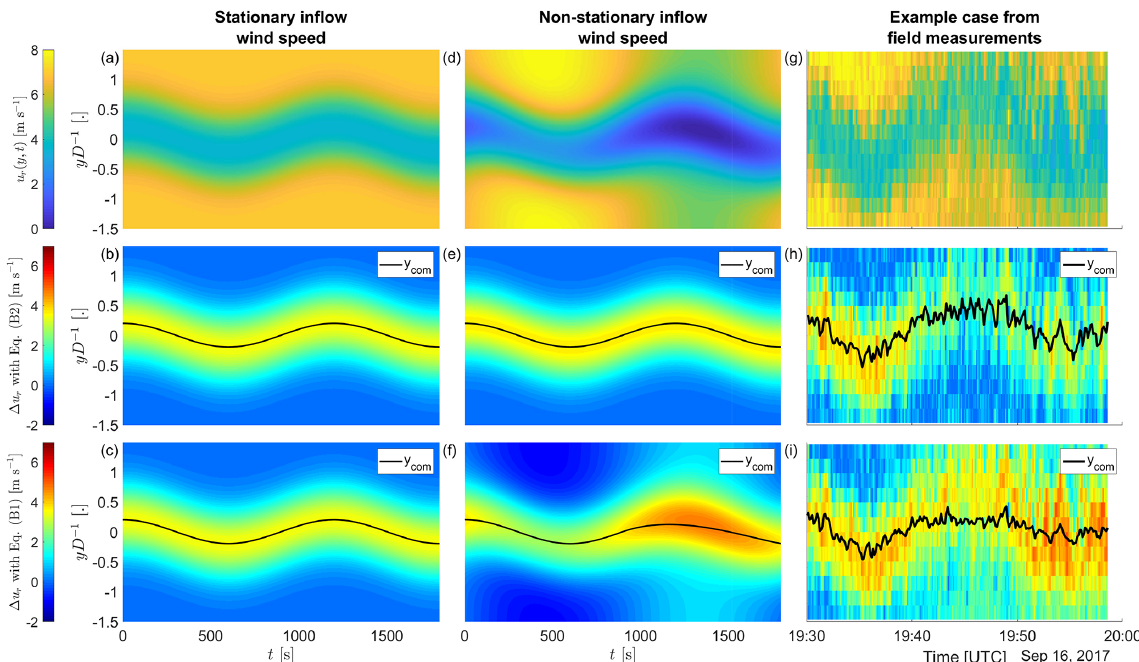
Figure B1. Time series of velocity profiles (a, d, g) and derived velocity deficits with Eq. (B2) based on max y ( u r ( x,y,t )) (b, e, h) and with Eq. (B1) based on u hub (c, f, i) . The left two columns present a Gaussian wake with sinusoidal wake meandering for a constant inflow wind speed (a–c) and a non-stationary inflow wind speed (d–f) . The right column (g–i) shows an example case from the data set presented in Sect. 3, which was selected for its pronounced differences between the two velocity deficit